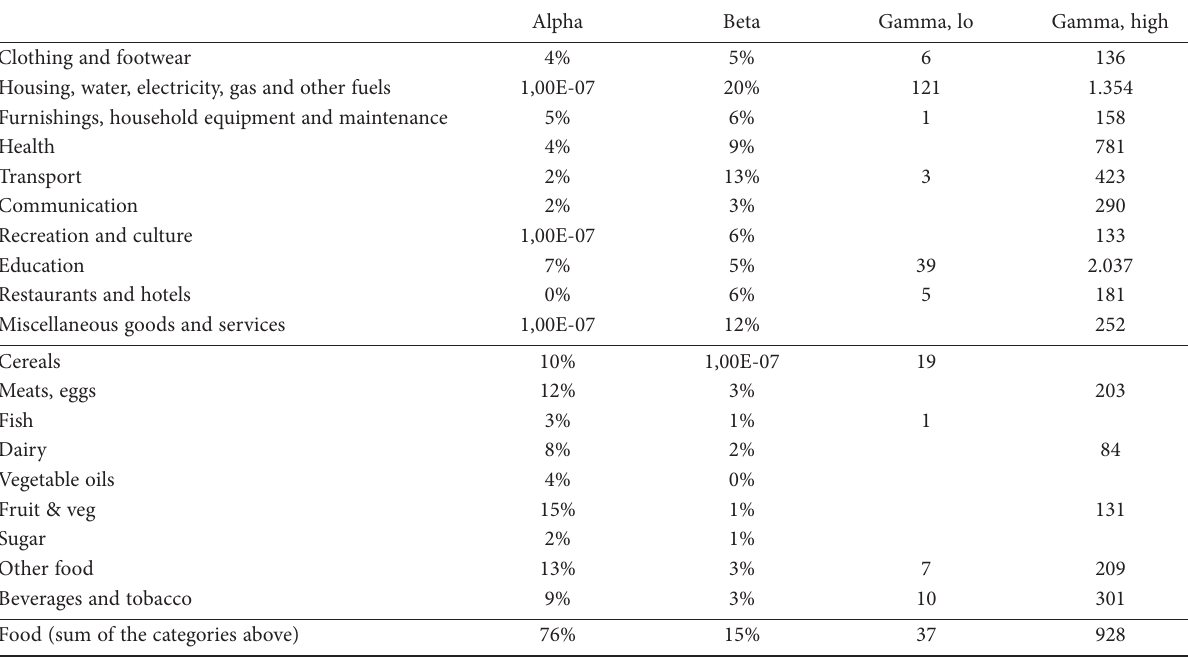
Table 9. Estimated base coefficients for selected